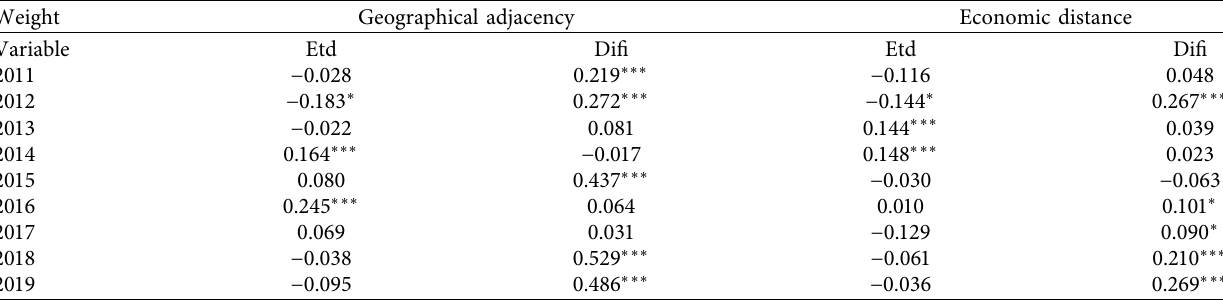
Table 4: Spatially relevant